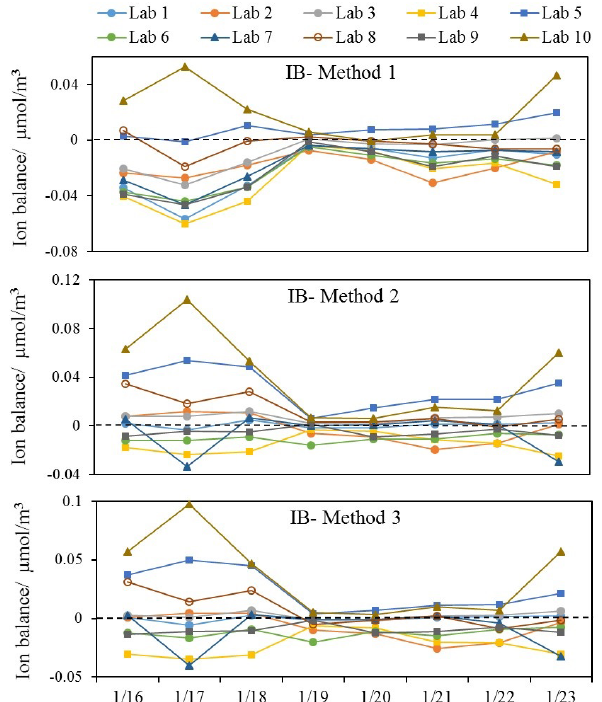
Figure 4. Ion balance in all labs applying different methods (nega- tive values reflect the excessive cations to neutralize anions).